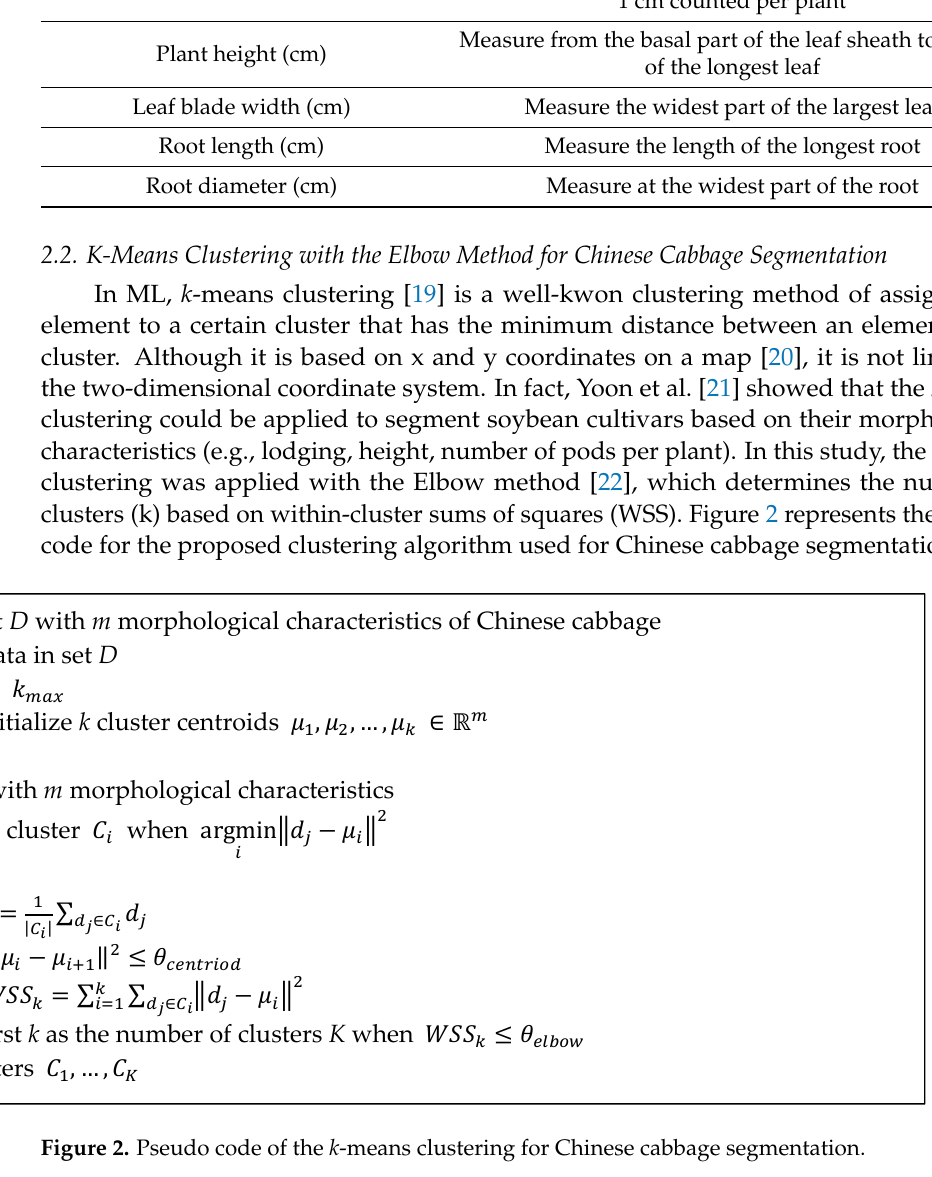
In Figure 2, each normalized data 𝑑 (cid:3037) ∈ 𝐷 involving m morphological characteristics of Chinese cabbage are assigned to k clusters. However, since the number of clusters ( k ) is not determined, the k -means is conducted under different k values (i.e., 𝑘 = 2 to 𝑘 (cid:3040)(cid:3028)(cid:3051) , which is the maximum number of potential clusters in the segmentation process). Each clustering process is completed when the clustering result is less than or equal to the given threshold ( 𝜃 (cid:3030)(cid:3032)(cid:3041)(cid:3047)(cid:3045)(cid:3036)(cid:3042)(cid:3031) ). On the other hand, only cluster information satisfying 𝑊𝑆𝑆 (cid:3038) ≤ 𝜃 (cid:3032)(cid:3039)(cid:3029)(cid:3042)(cid:3050) is selected as the final outcome with k . The proposed clustering was used to organ- ize multivariate datasets collected from field research into isolated groups of similar Chi- nese cabbage varieties. The head weight, number of inner leaves, number of outer leaves, plant height, leaf blade width, root length, and root diameter were used to identify groups of similar Chinese cabbage varieties (i.e., 𝑚 = 7 ). Figure 3 represents the WSS values under different k from 1 to 10 (i.e., k max = 10). Ini- tially, the WSS value is 5.60 ( k = 1), but as the value of k increases, its value decreases. After k = 3, the difference between WSS k and WSS k +1 is smaller than θ elbow = 0.5. Thus, this study selected 3 as the number of clusters ( k ) according to the Elbow method.